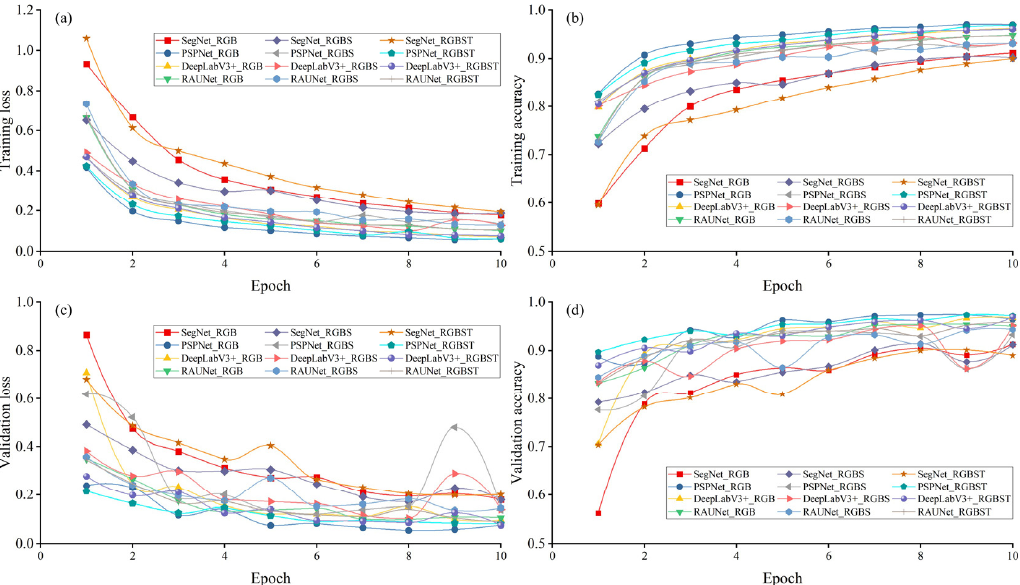
Figure A1. Training and validation curves for multi-class classification. ( a ) Training loss; ( b ) training accuracy; ( c ) validation loss; ( d ) validation accuracy.